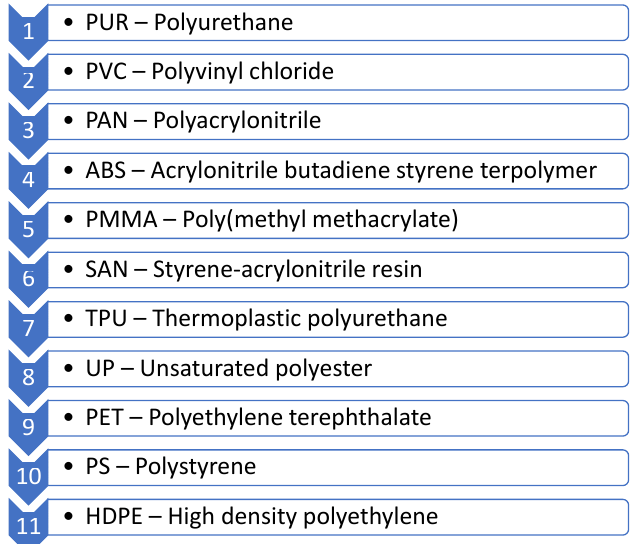
Figure 13. Hazard scale of plastic microparticles.